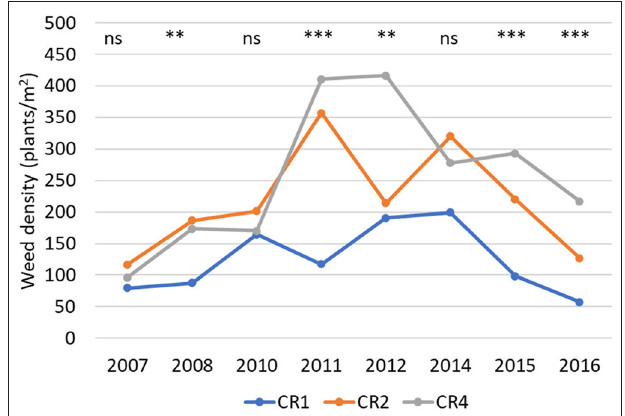
FIGURE 3 | The average weed density (plants/m 2 ) in spring wheat in different years and crop rotations. CR1, wheat monoculture; CR2, wheat every 2nd year; CR4, wheat every 4th year. Statistically significant differences: ns = not significant, ** p < 0.01, *** p < 0.001.